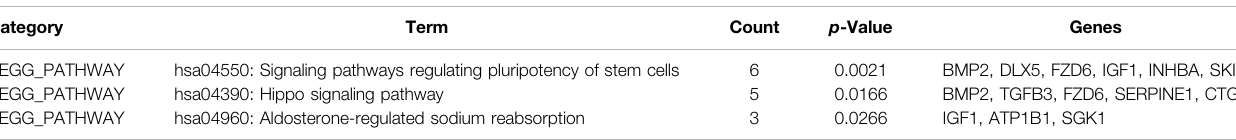
TABLE 2 | KEGG pathways enrichment analyses of upregulated DEGs.